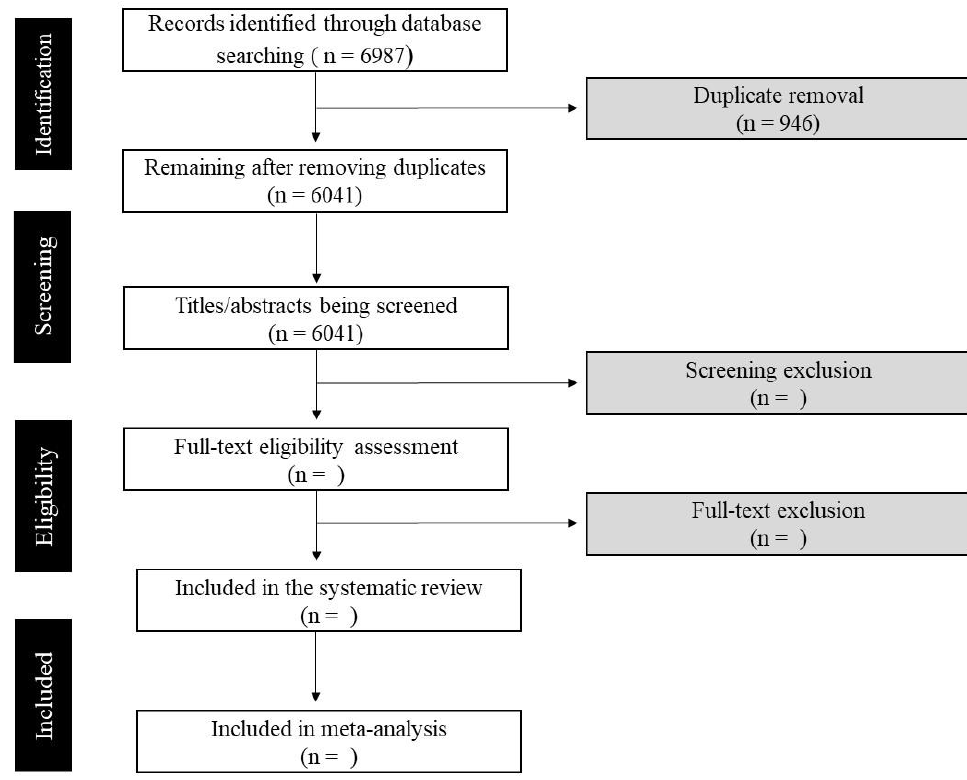
Figure 1. Study identification and screening flow chart.